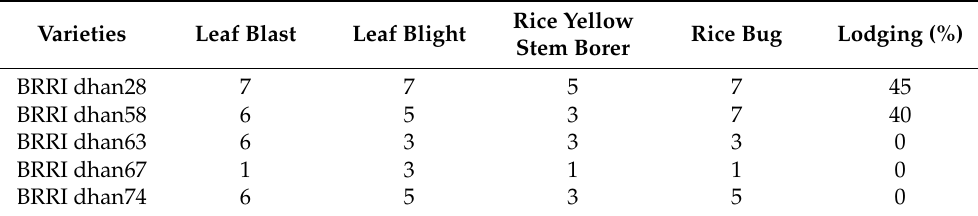
Table 6. SES scoring of diseases and insects, and lodging percentage of varieties (average of 15 farmers). Varieties Leaf Blast Leaf Blight